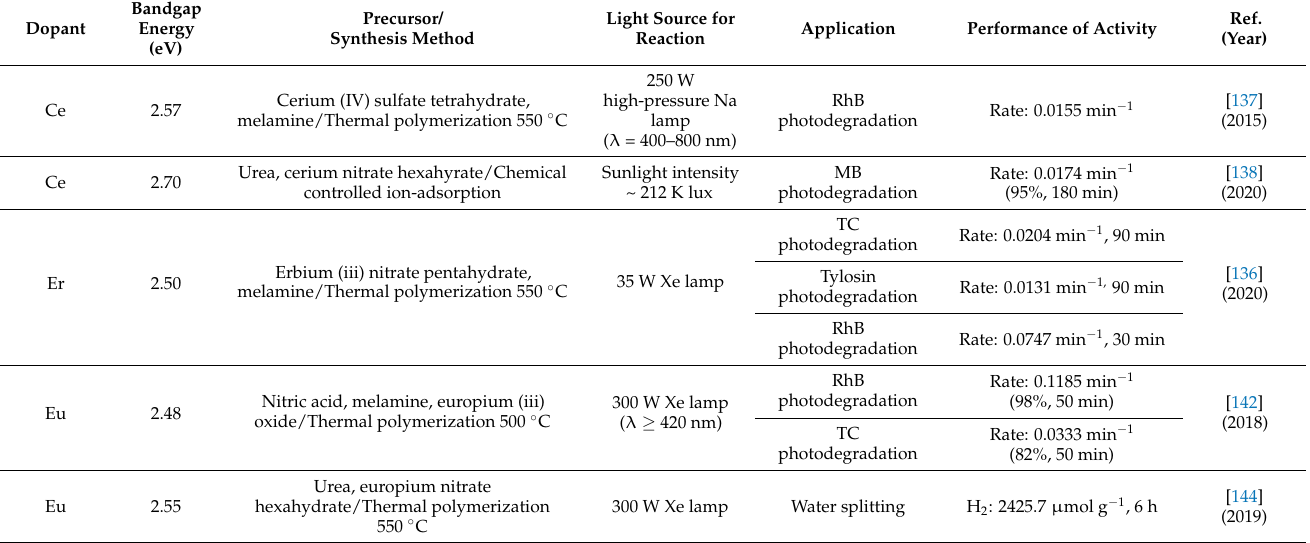
Table 4. The summary of rare-earth single-doped and co-doped